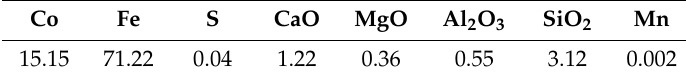
Table 8. Main chemical composition of cobalt concentrate (%).